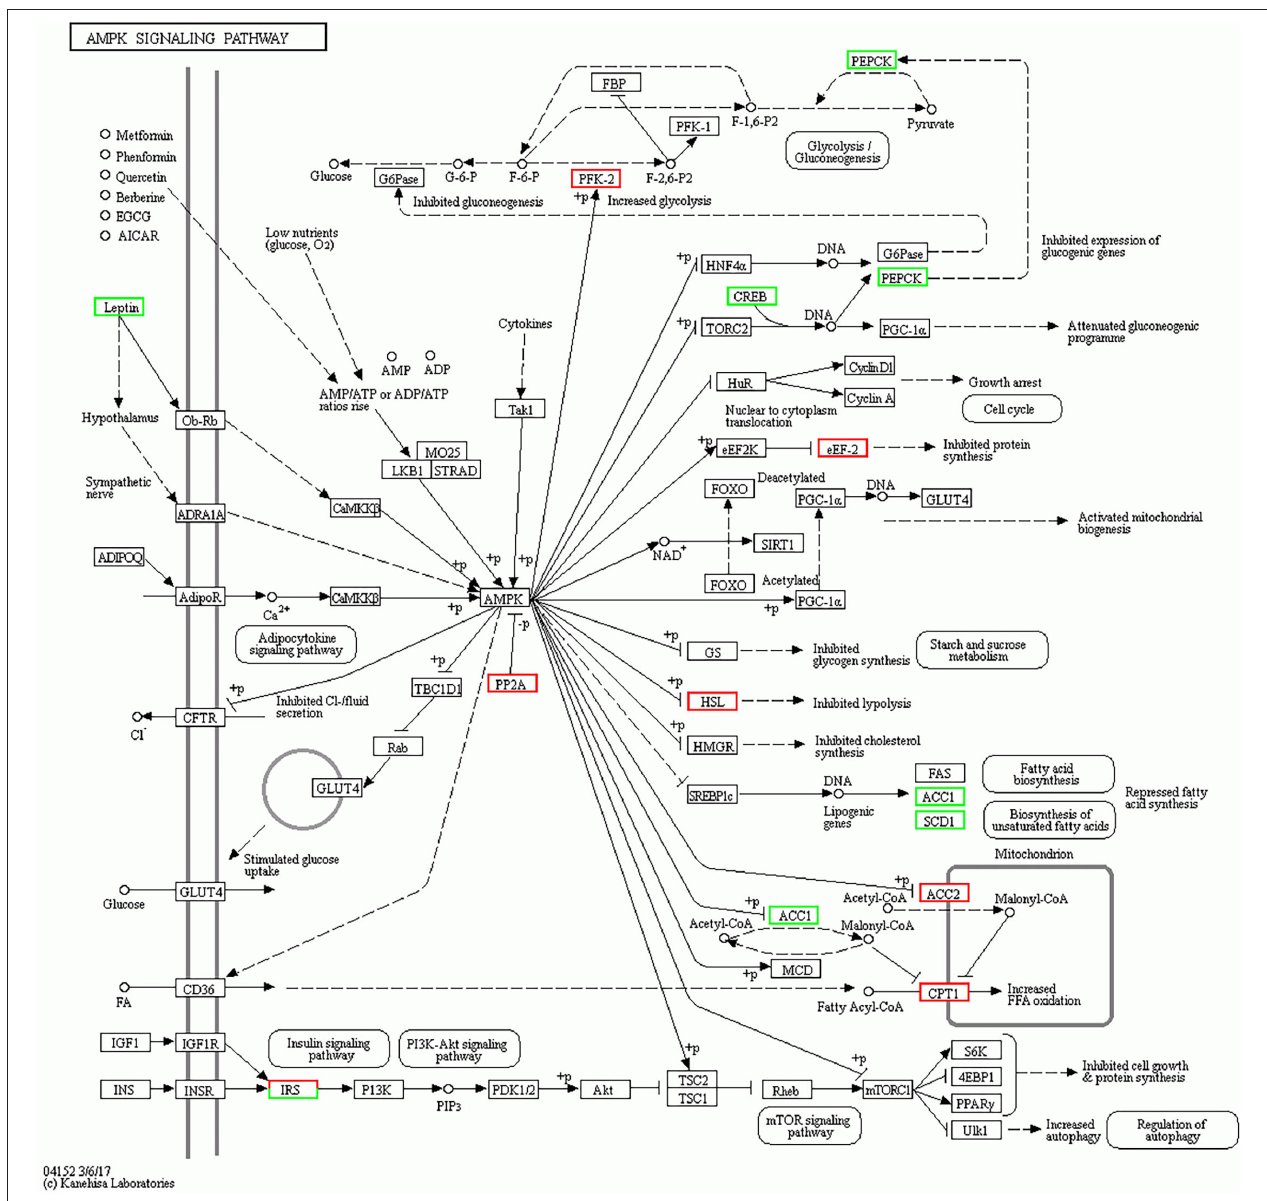
FIGURE 3 | AMPK signaling pathway in the 4 months vs. 1.5 years group. The white square represents a gene or protein, the red square is the up-regulated genes in the pathway at this time, the green square is the down-regulated genes in the pathway at this time.